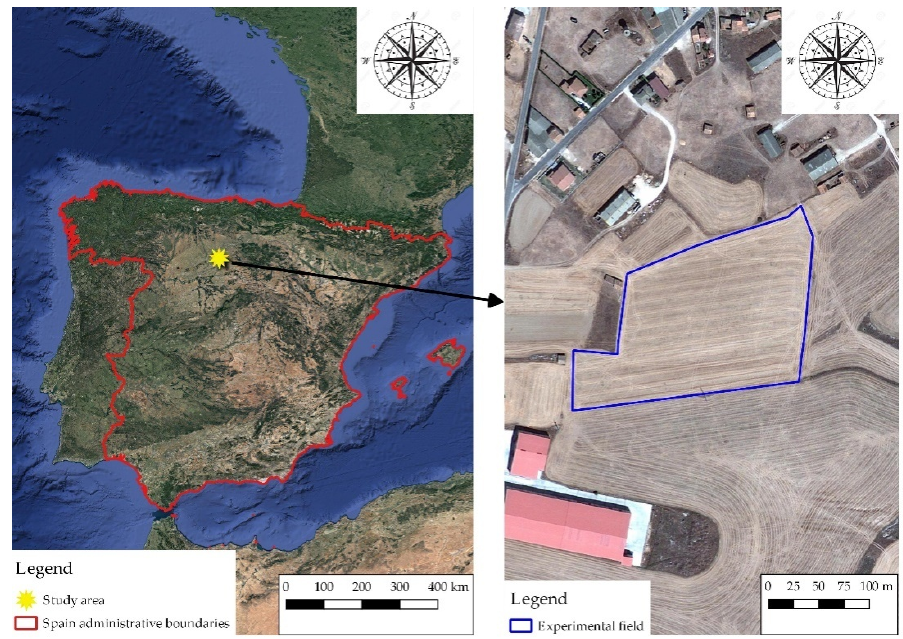
Figure 1. Map of the experimental field in Castilla y Leon region of Spain.